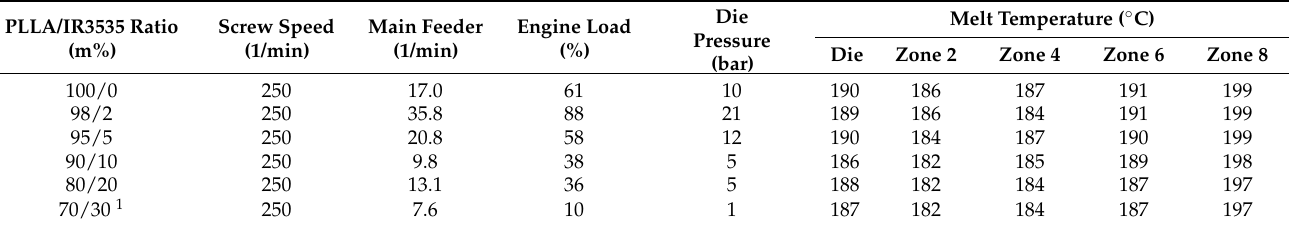
Table 1. Sample composition and extrusion